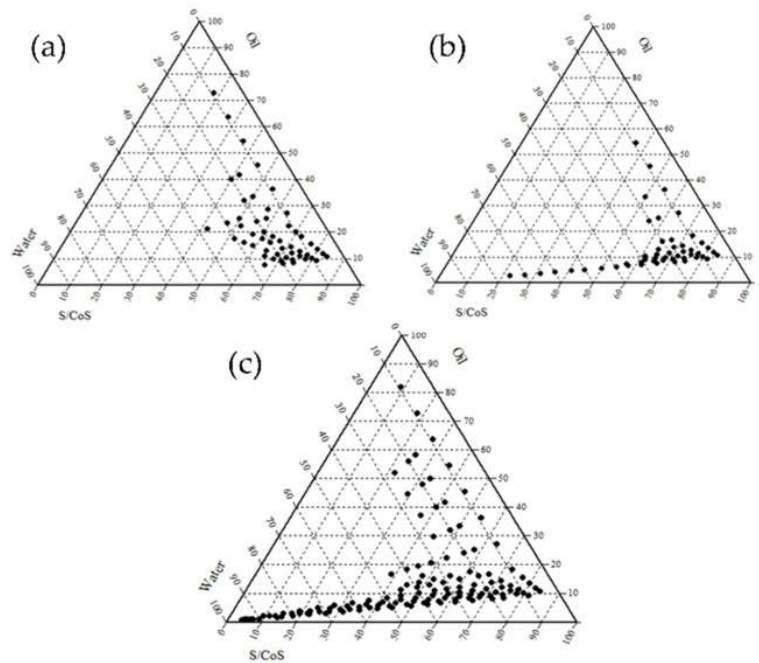
Figure 1. Pseudo-ternary phase diagram of microemulsion composed of oil (IPM), surfactant (Labrasol, Tween 80 and Cremophor EL)-co-surfactant (Transcutol HP ® ) mixture (1:1 ratio, w / w ), and water ( a ) oil (IPM), S/CoS (Labrasol:Transcutol ® HP, 1:1); ( b ) oil (IPM), S/CoS (Tween 80:Transcutol ® HP, 1:1); ( c ) oil (IPM), S/CoS (Cremophor EL: Transcutol ® HP, 1:1).